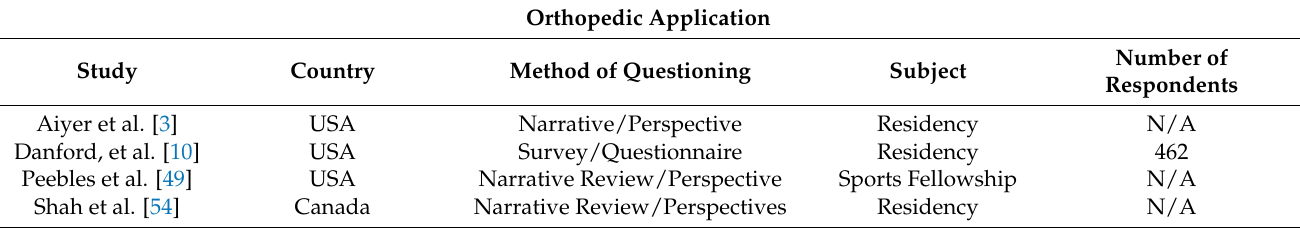
Table 3. Characteristics of relevant publications on orthopedic